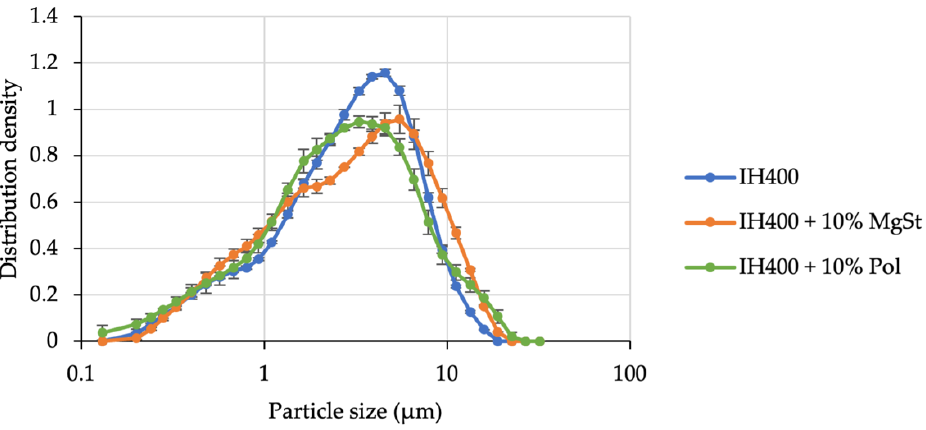
Figure 5. Particle size distribution after the optimisation of grinding pressures in the air jet mill. n = 3, error bars denote standard deviation.